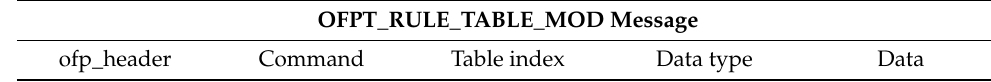
Table 2. The composition of the OFPT_RULE_TABLE_MOD message.